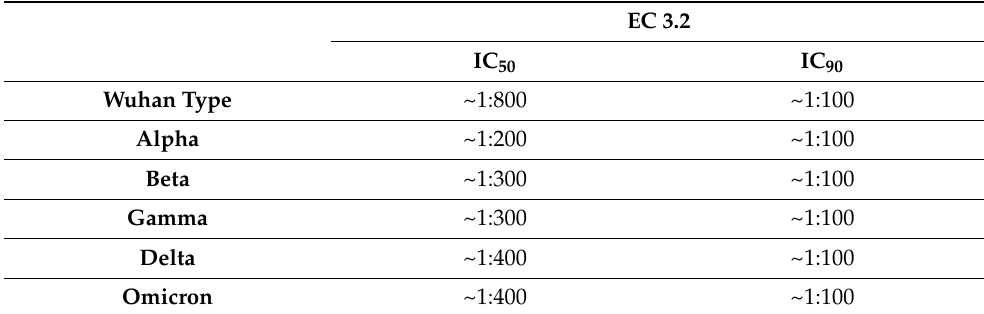
Table 2. IC 50 and IC 90 values of EC 3.2 against SARS-CoV-2 Wuhan type and VoCs in Calu-3 cells.